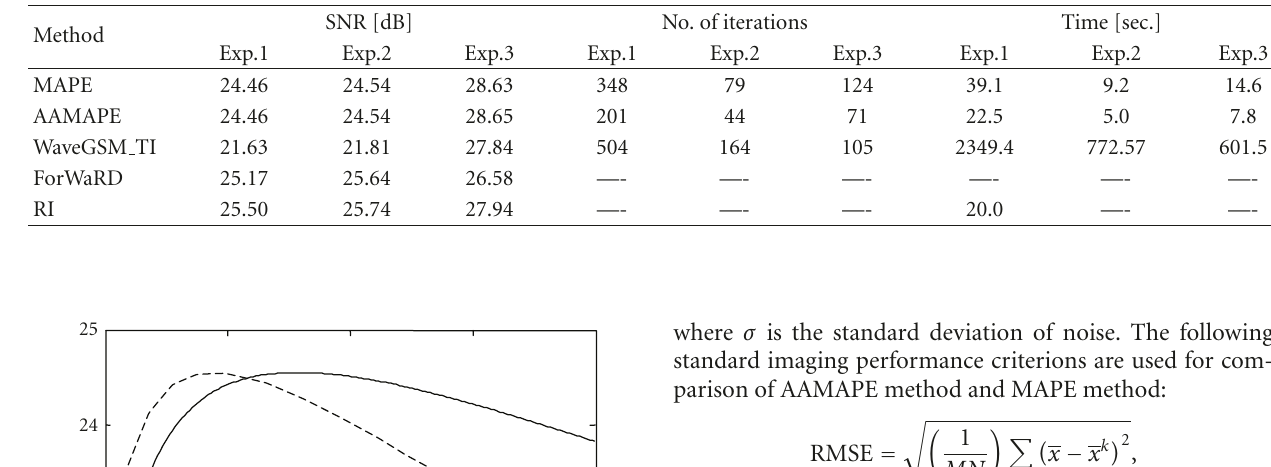
Table 2: SNR, iterations, and time for MAPE, AAMAPE, WaveGsm TI [32], ForWaRD [33], and RI [34].